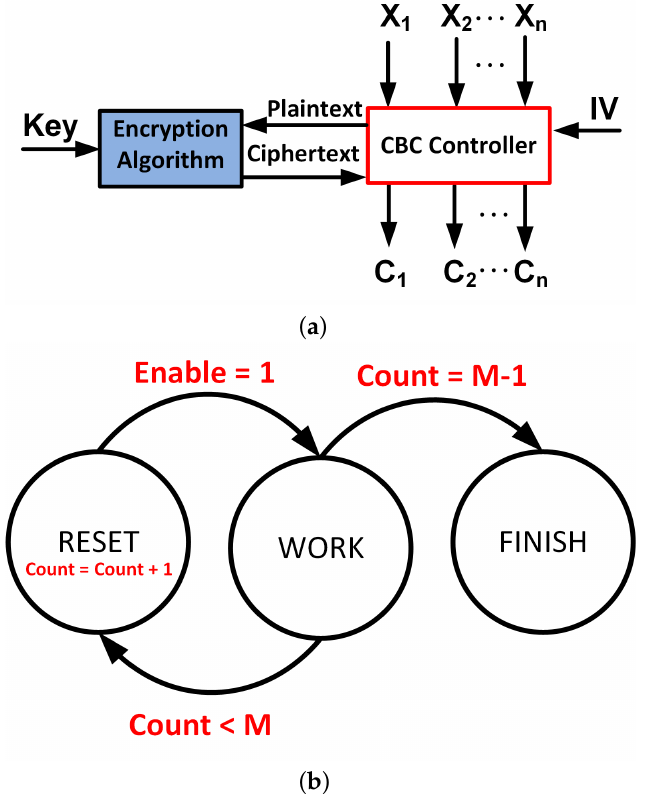
Figure 2. ( a ) Proposed hardware architecture of CBC encryption and ( b ) Finite State Machine (FSM) of CBC sequential